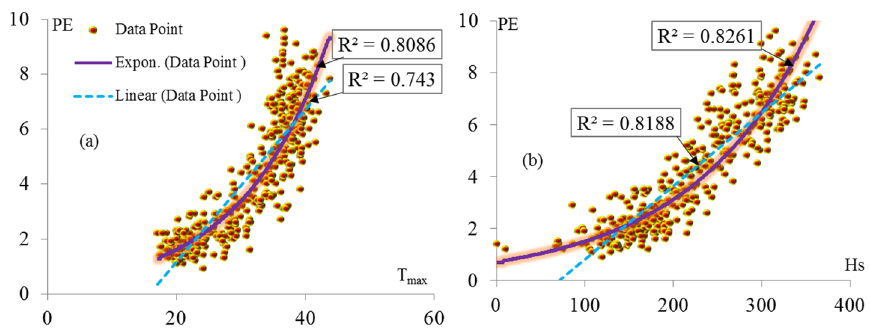
Figure 5. Schematic view of basic function using linear and exponential forms for data of ( a ) maxi- mum temperature and ( b ) hours of sunshine.